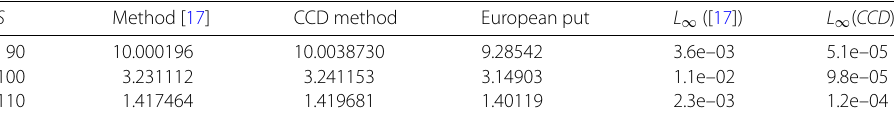
Table 5 Values of American put options obtained by the CCD method under the Merton model. The reference values are 10.003822 at S = 90, 3.241251 at S = 100, and 1.419803 at S = 110 [16]. The truncated domain is [–1.5,1.5] and λ = 0.1, M = 128, and N = 25